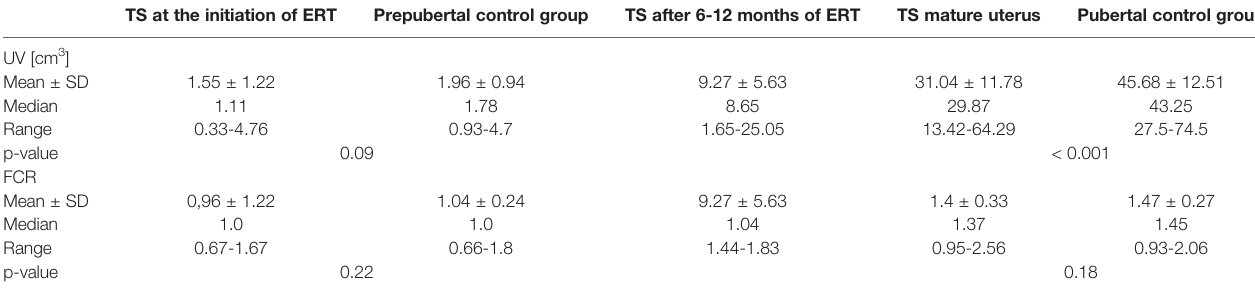
TABLE 2 | Ultrasound parameters of the uterus in Turner syndrome patients and in the control group.